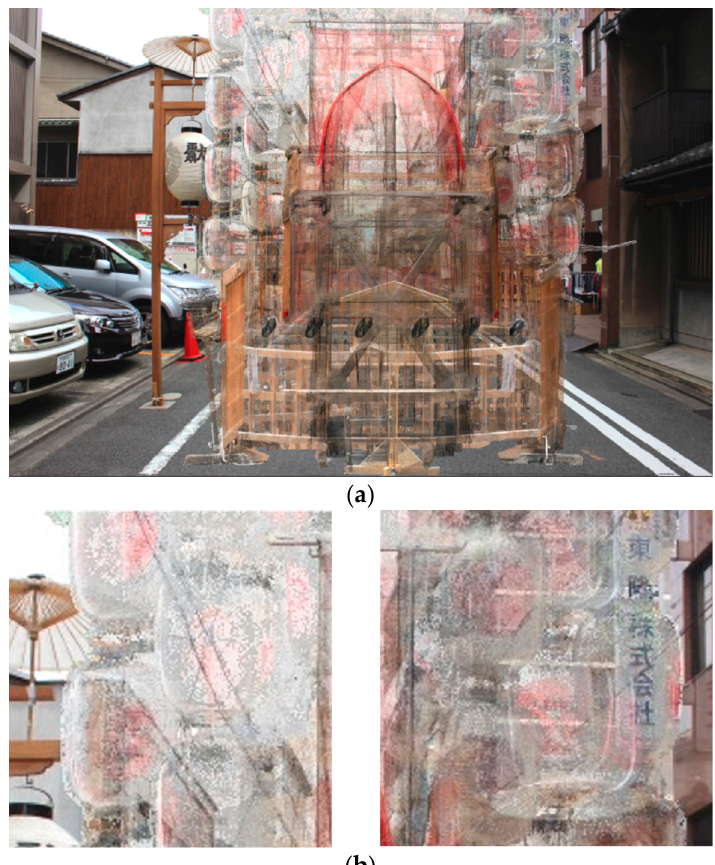
Figure 7. Result of improved fused transparent visualization by the proposed method: ( a ) visualization result by the proposed method and ( b ) local details of the visualization result of ( a ).